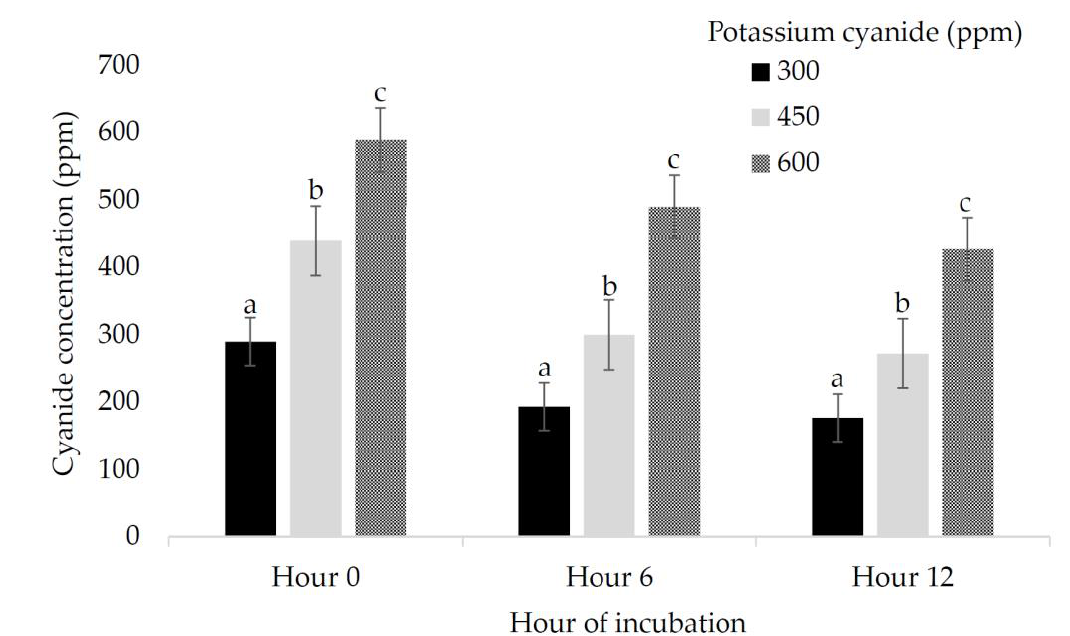
Figure 1. Influence of potassium cyanide (KCN) levels on ruminal cyanide concentration (ppm) at various hours of incubation [a–c Means in the same hour with different superscripts differ ( p < 0.05)].